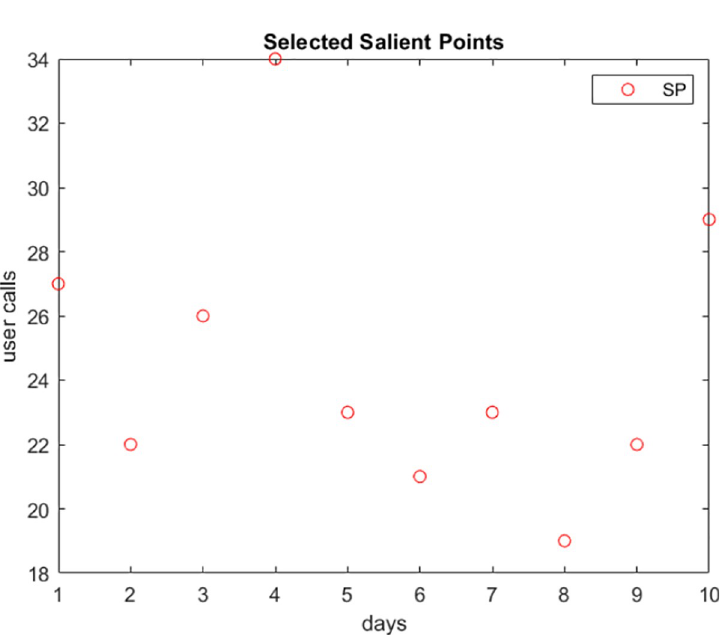
Fig 5. The representative salient points computed from the calling activity in Fig